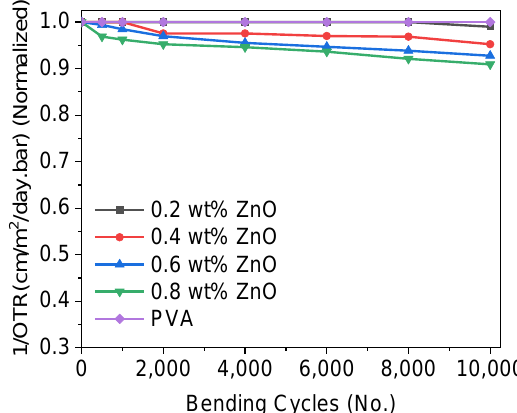
Figure 9. OTR inverse values of PVA films with different ZnO concentrations vs. several bending cycles, where PVA is denoted by a purple curve, the black curve refers to PVA films containing 0.2 wt% ZnO, the red curve refers to 0.4 wt% ZnO, the blue curve refers to 0.6 wt% ZnO, and the green curve represents 0.8 wt% of ZnO in PVA films.